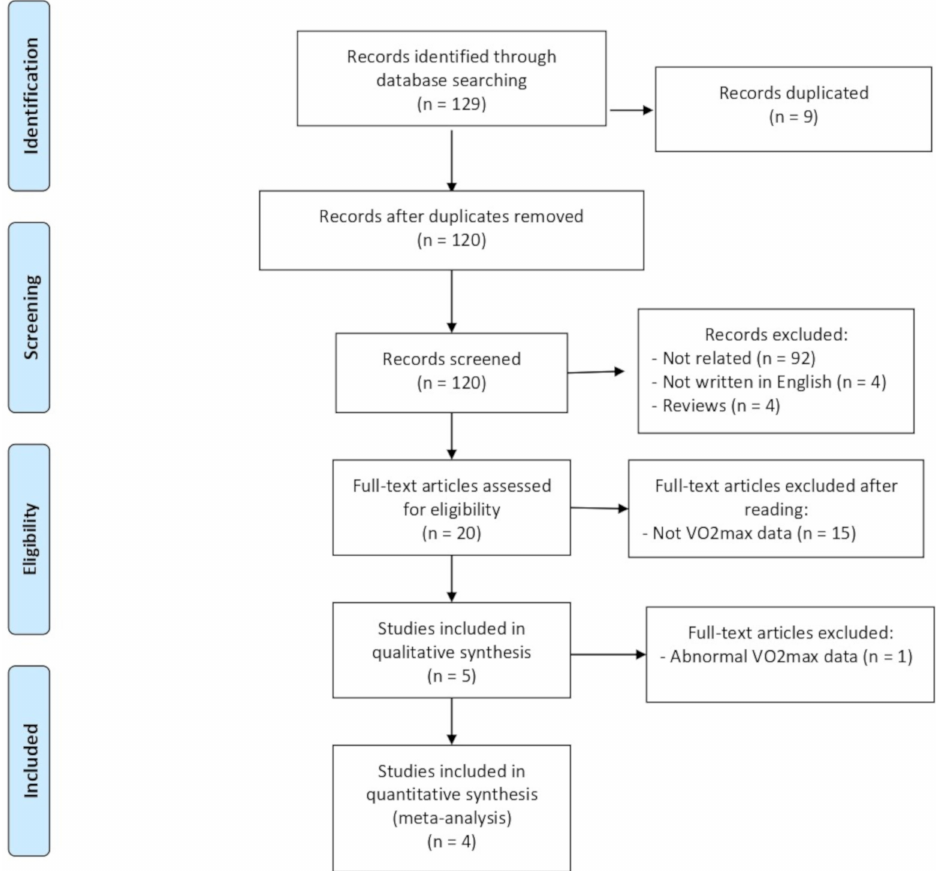
Figure 1. Flow chart delineating the complete systematic review